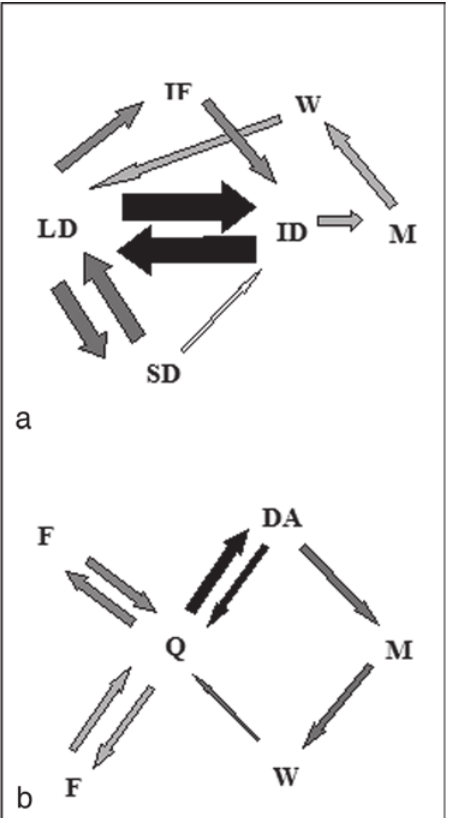
Fig. 2. Schematic diagram of behavioral units of sequence of courtship and mating in Austrolebias reicherti . Abbreviations of units shown in Table 1. Broken lines indicate alternative (less frequent) sequence. Table 1. Behavioral unit description, relative frequency and time of males and females of Austrolebias reicherti ; SD = standard deviation.